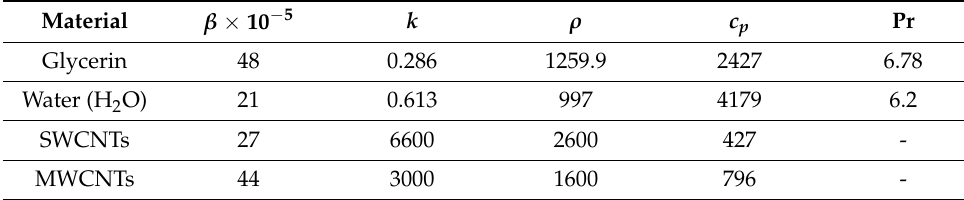
Table 1. Thermo-physical characteristics of CNTs and fluids